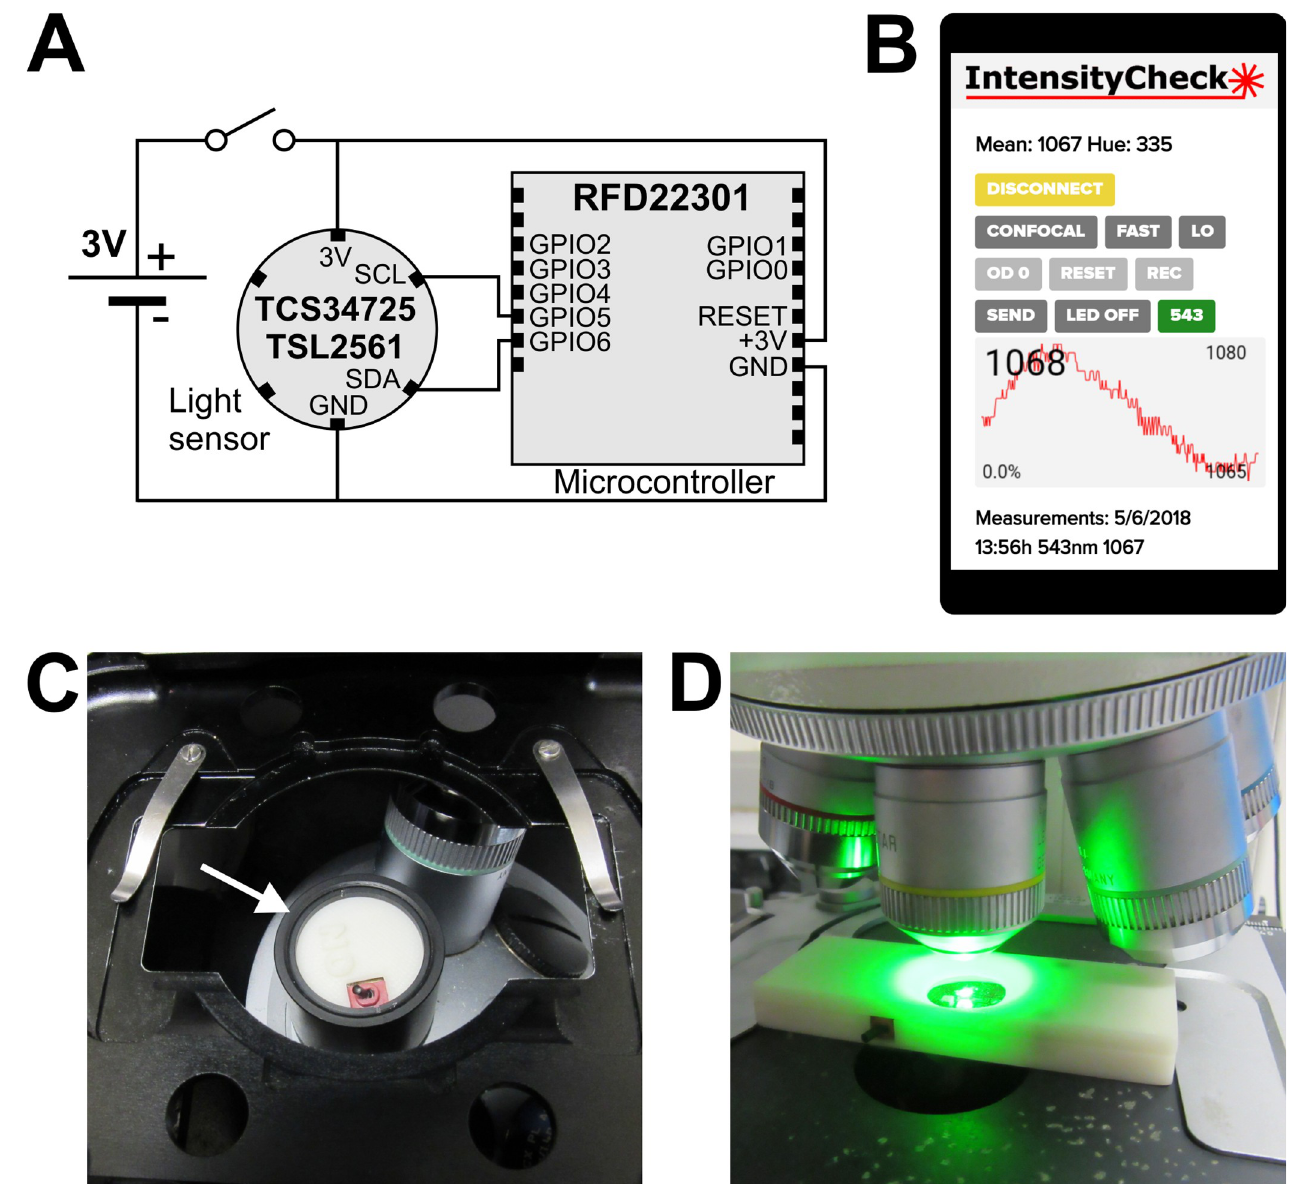
Fig 1. The IntensityCheck sensors and Android app. (A) Electrical wiring diagram of the TCS34725 or TSL2561 light sensor circuit boards to the RFduino microcontroller. (B) Smartphone screenshot of the IntensityCheck App. (C) The IntensityCheck sensor mounted as objective lens sized device on an inverted confocal microscope stand (arrow). (D) The slide shaped sensor on the stage of an upright fluorescence microscope. The pictures in (C) and (D) were taken by the